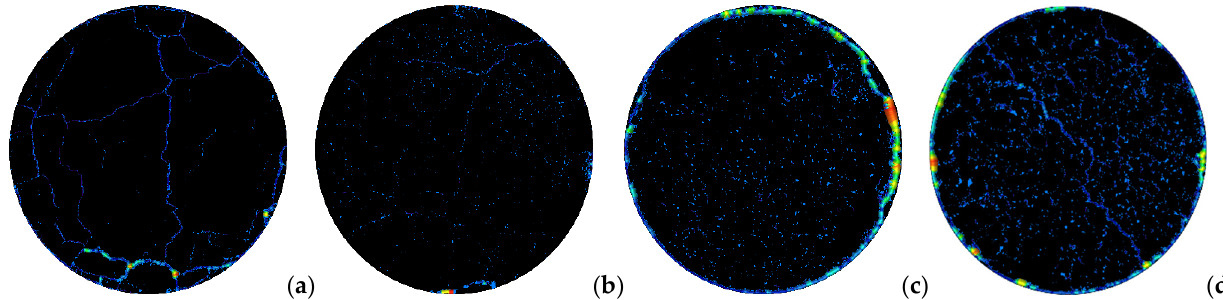
Figure 13. Cracks in soil sample after 4 WD cycles: ( a ) 0.25 mm; ( b ) 0.50 mm; ( c ) 2.00 mm; ( d ) 5.00 mm.